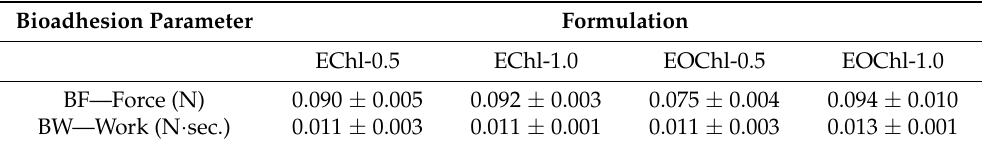
Table 4. Bioadhesion in human skin at 35.0 ◦